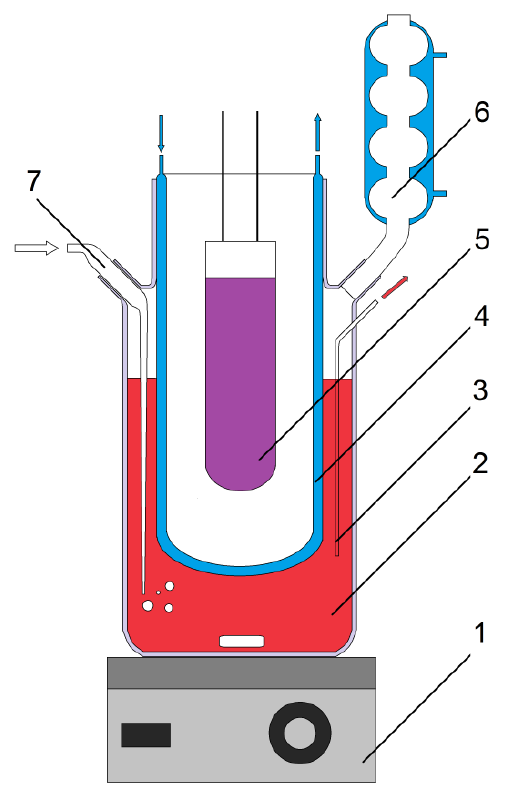
Figure 14. Scheme of the photoreactor. 1—magnetic stirrer, 2—reaction flask, 3—sampling access, 4—quartz cooler, 5—UV lamp, 6—condenser and 7—air supply.